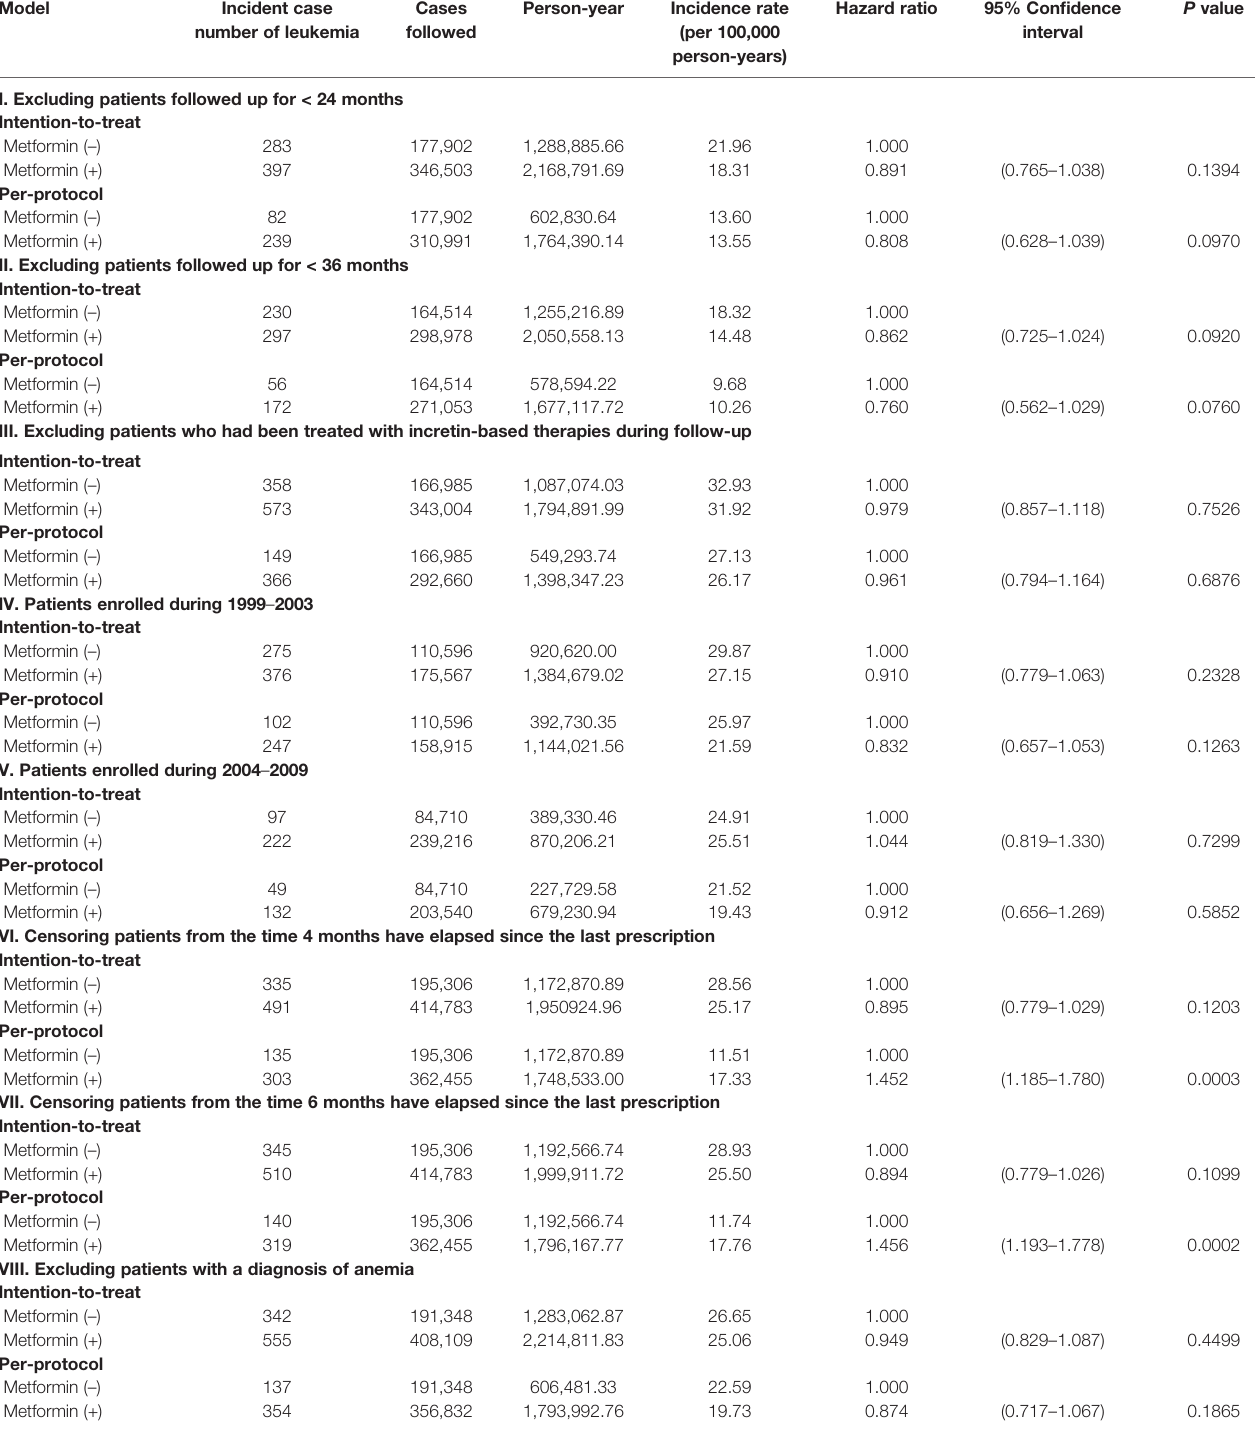
TABLE 3 | Sensitivity